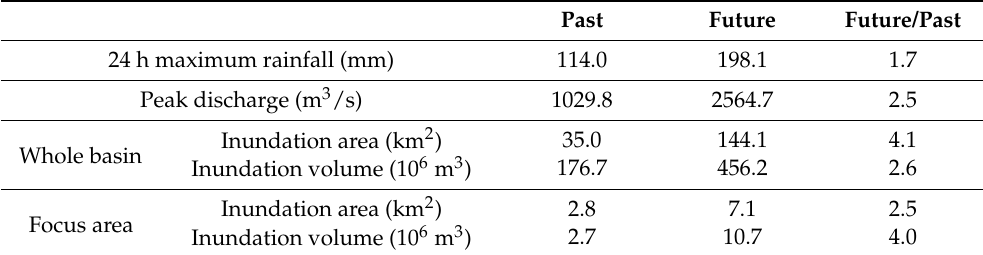
Table 2. Comparisons between the past and future climate from the aspects of 24 h maximum rainfall, peak discharge, inundation extent, and inundation